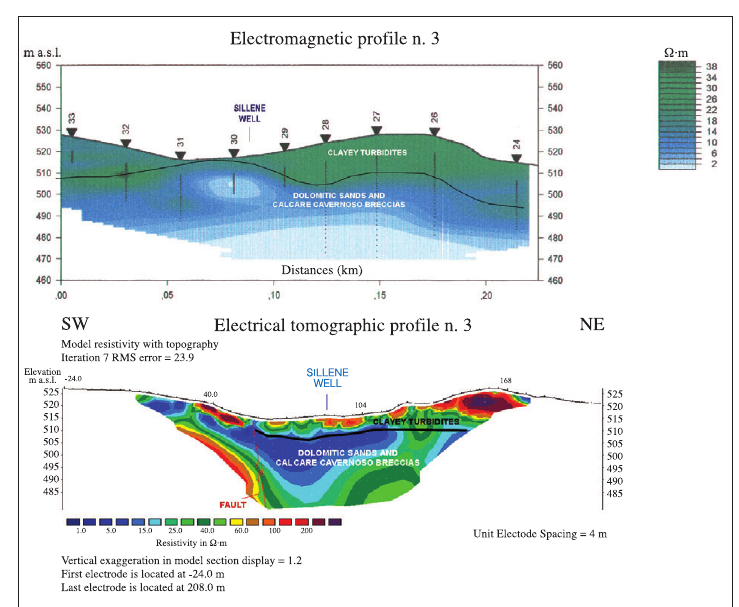
Fig. 7. Profile n.